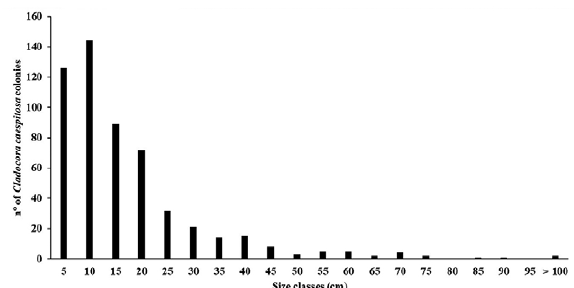
Fig. 3. – Size class structure of Cladocora caespitosa colonies starting at the class interval of 5 cm (colonies measuring 1-5 cm)